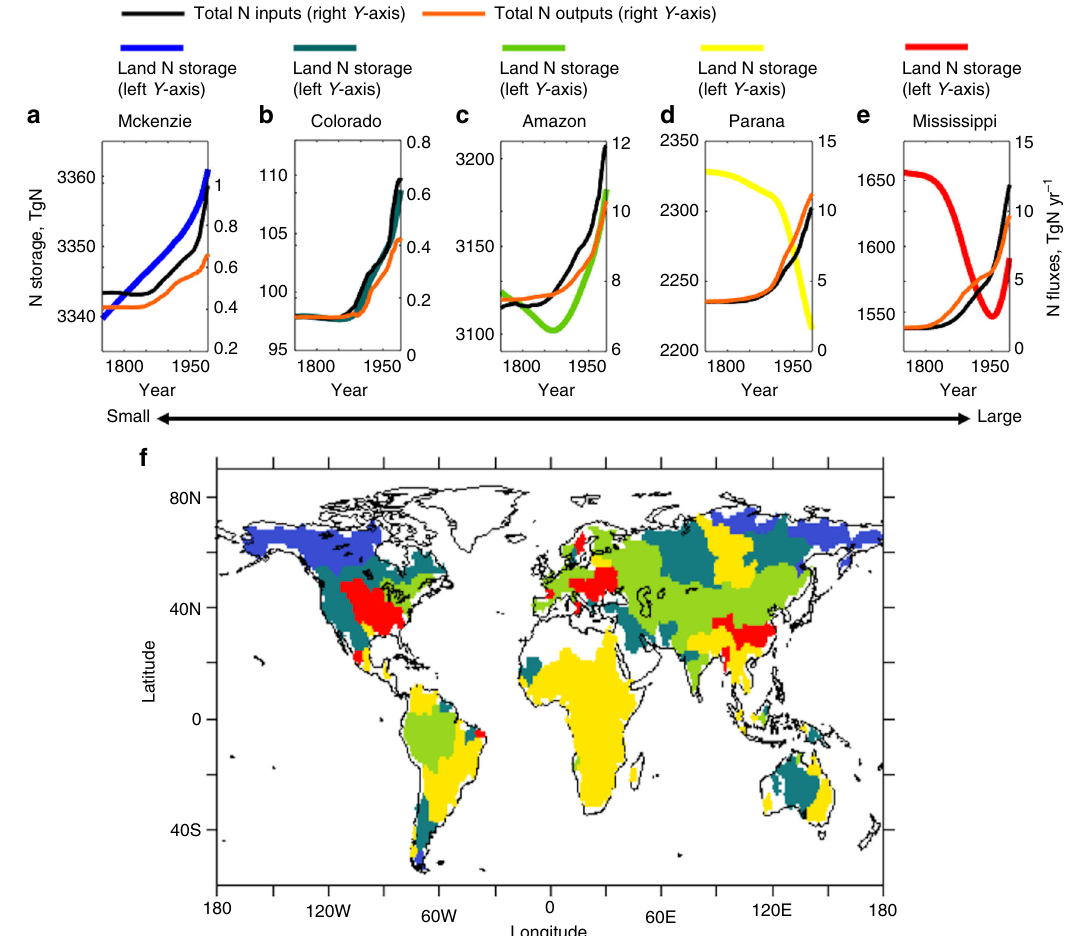
Fig. 6 Small-to-Large LULCC footprints. a – e Small (blue), small-to-medium (blue-green), medium (green), medium-to-large (yellow), and large (red) LULCC footprints, re fl ected by fi ve distinct basin-scale pathways of land N storage from 1750 to 2005. f 159 river basins shaded by fi ve distinct colors representing the fi ve LULCC footprints. Small footprint basins account for 21 of the 159 basins, 7% of the area of the 159 basins, and 1% of the total N outputs from the 159 basins. Small-to-medium footprint basins account for 40 basins, 21% of the area, and 10% of the outputs. Medium footprint basins account for 30 basins, 27% of the area, and 25% of the outputs. Medium-to-large footprint basins account for 57 basins, 37% of the area, and 48% of the outputs. Large footprint basins account for 11 basins, 8% of the area, and 15% of the